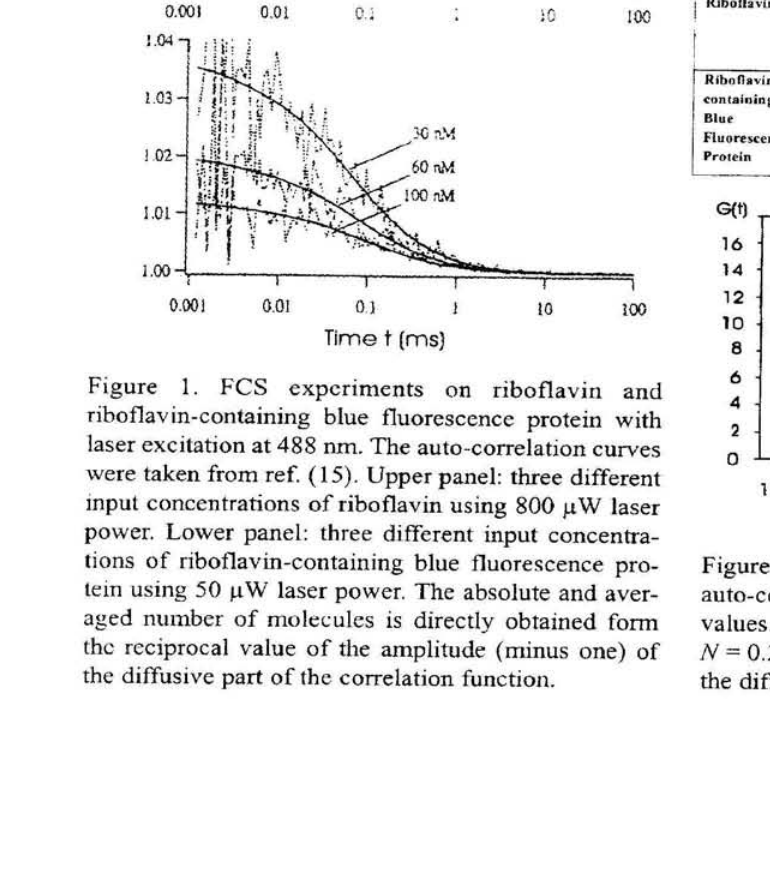
Pteridines/Vol. 13/No.